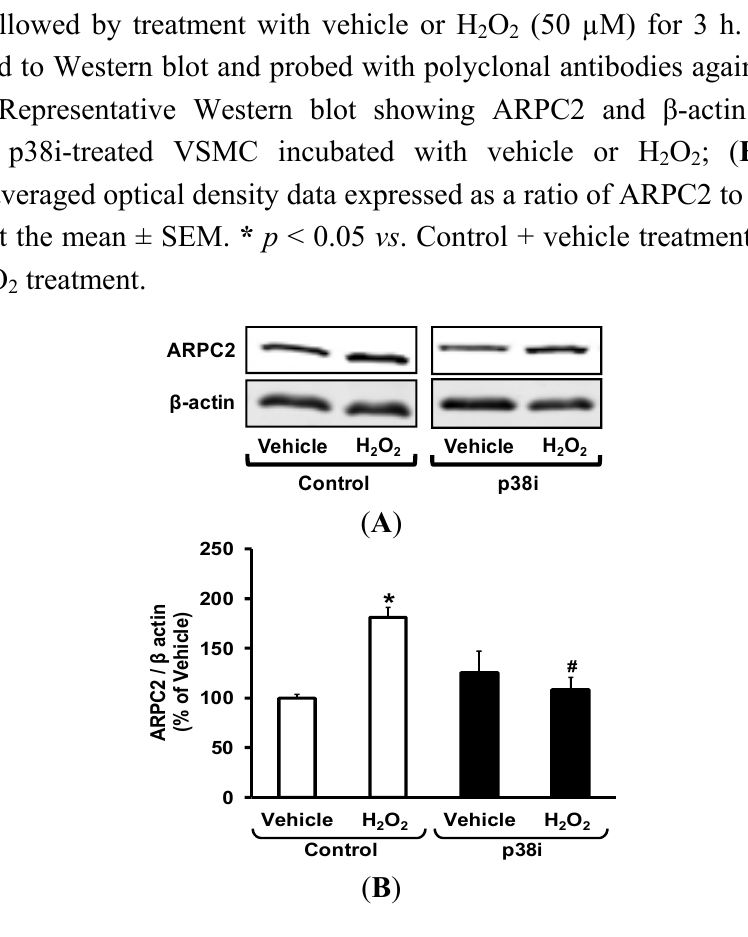
O -induced ARPC2 expression. 2 2 O (50 µM) for 3 h. VSMC lysates 2 2 O ; ( B ) Bar graphs 2 2